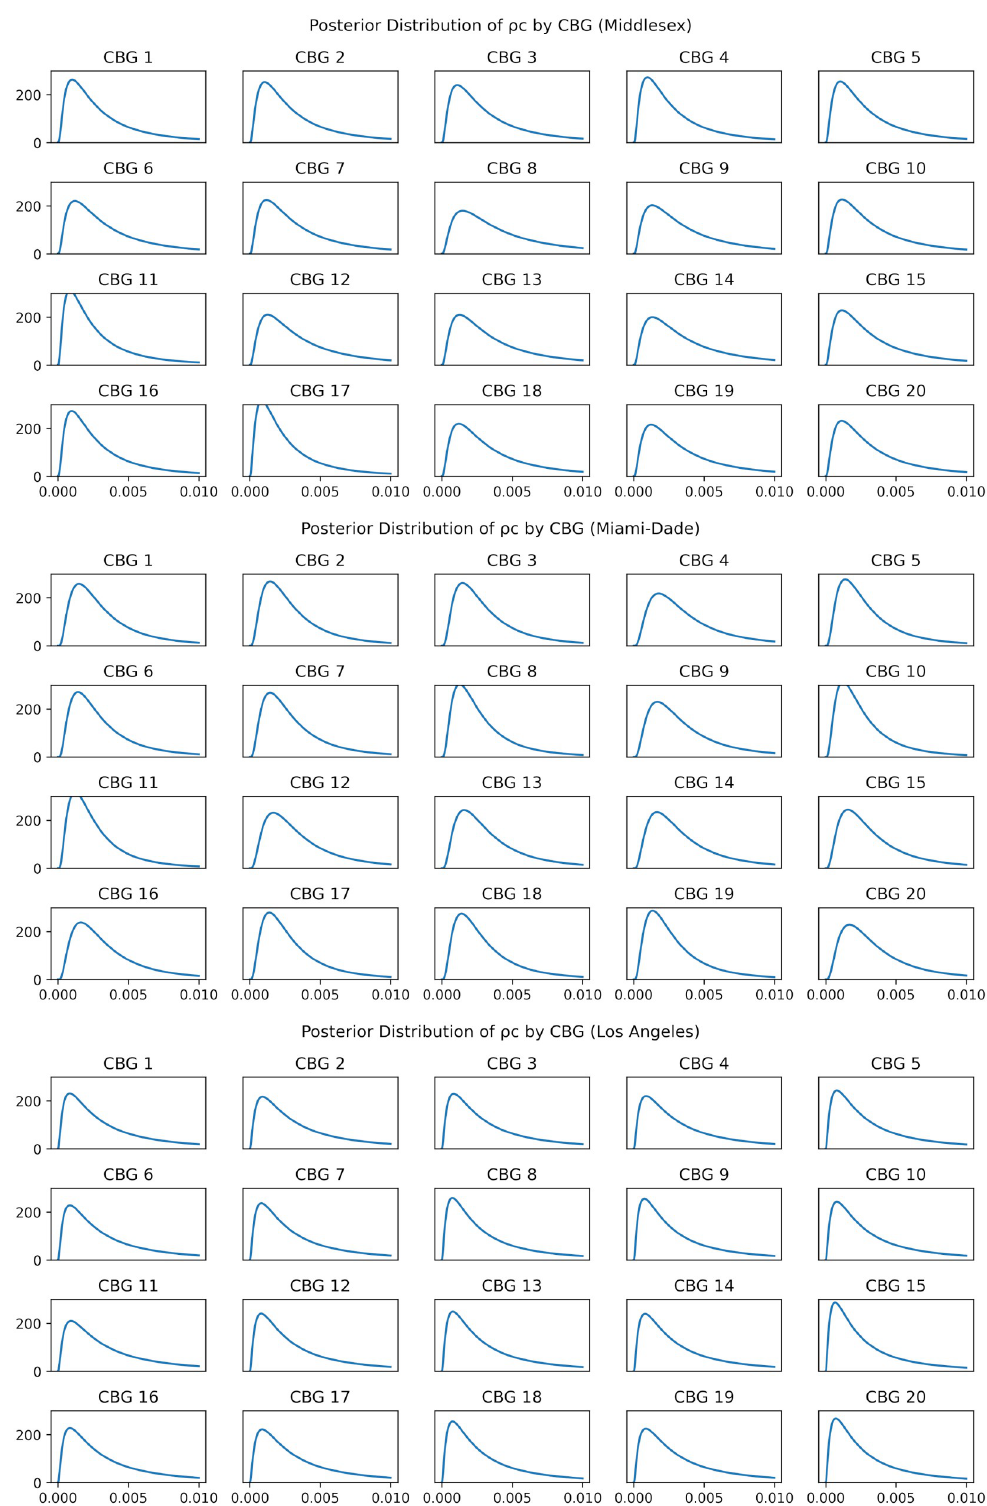
Fig 12. Posterior distribution of ρ c for communities and b t have no correspondence across counties.